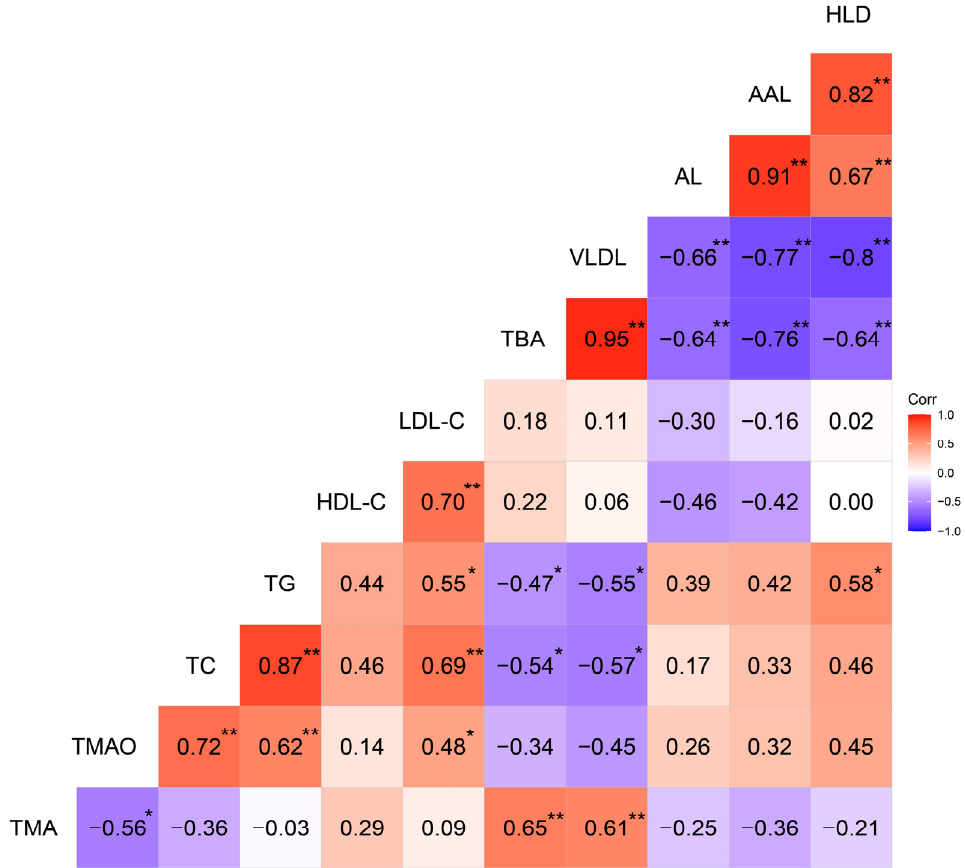
Figure 3. Heat map based on Pearson’s correlations for the relationship between serum trimethylamine N-oxide, trimethylamine, and lipid-deposition characteristics in the selected 18 hens at 62 weeks. The color scale represents Pearson’s correlation coefficients, with red and bluish violet representing positive and negative correlations, respectively. Ranging from 1.0 (maximum positive correlation) to -1.0 (maximum anti-correlation), with 0 indicating no correlation. TMA, trimethylamine; TMAO, trimethylamine N-oxide; TC, total cholesterol; TG, triglyceride; HDL-C, high-density lipoprotein cholesterol; LDL-C, low-density lipoprotein cholesterol; TBA, total bile acid; VLDL, very low density lipoprotein; AL, aortic lesion; AAL, aortic arch lesion; HLD, hepatic lipid deposition. * p < 0.05, ** p < 0.01.